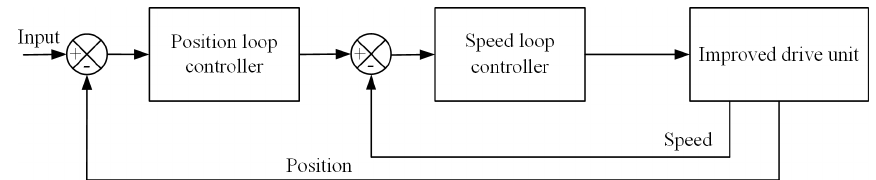
Figure 16. Control block diagram of position and speed double closed-loop control system.